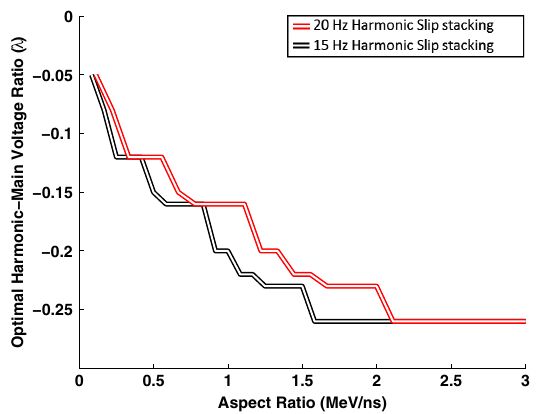
FIG. 13. Optimal harmonic-main voltage ratio λ for 99% admittance (at 99% efficiency) as a function of aspect ratio.